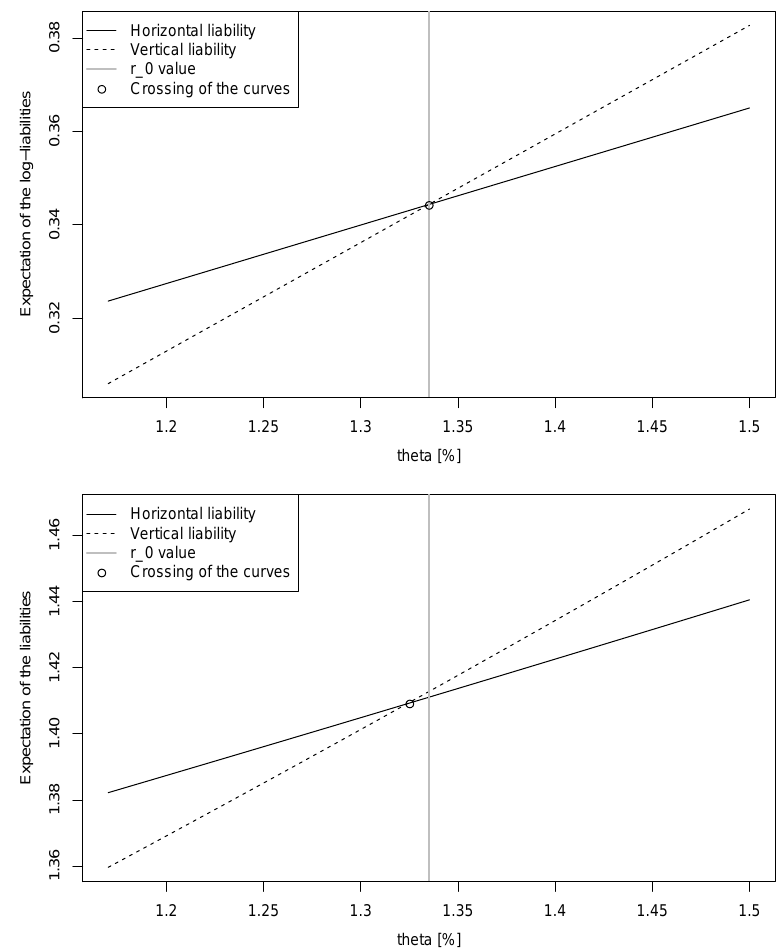
Figure 3. Comparison of the expectations of the log-liability (upper graph) and of the liability (lower graph) obtained using the horizontal and the vertical